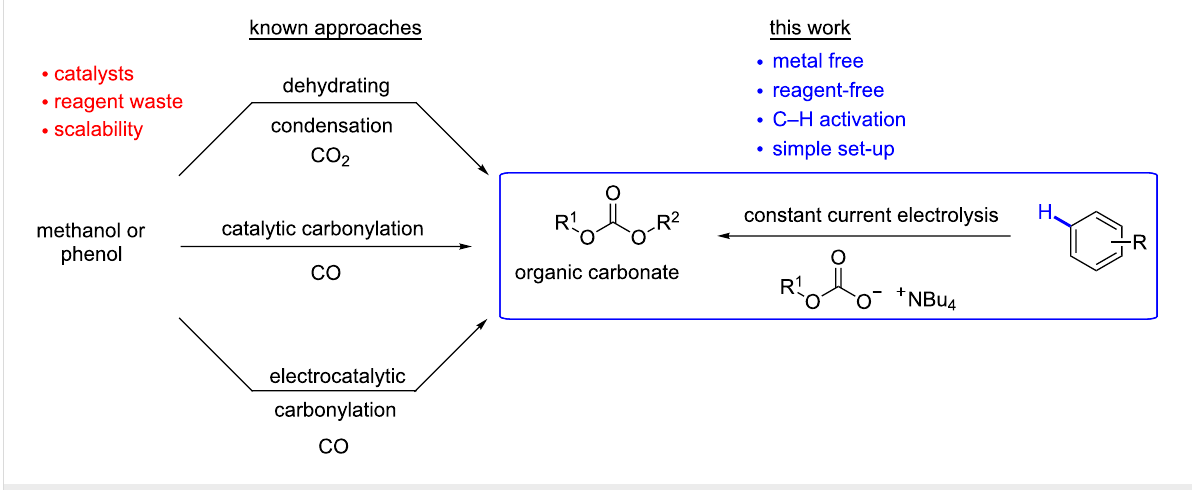
Figure 1: Current non-phosgene approaches to organic